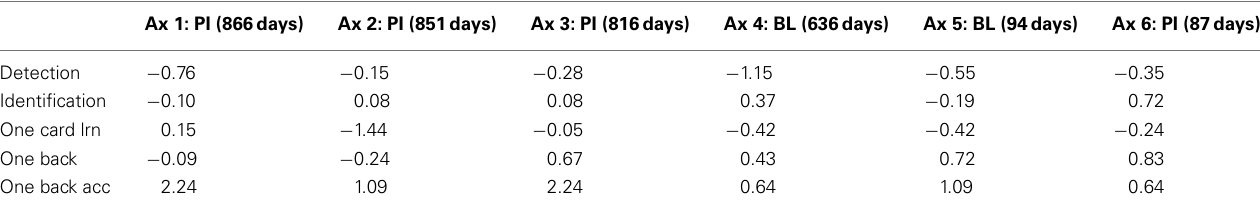
Table 1 | CogSport assessment results ( z -scores).